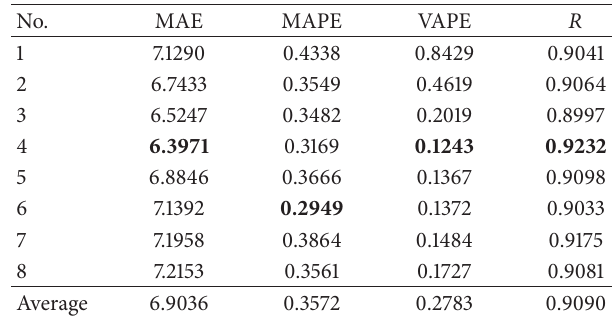
Table 1: Comparison of performance among WNNMs with differ- ent number of input